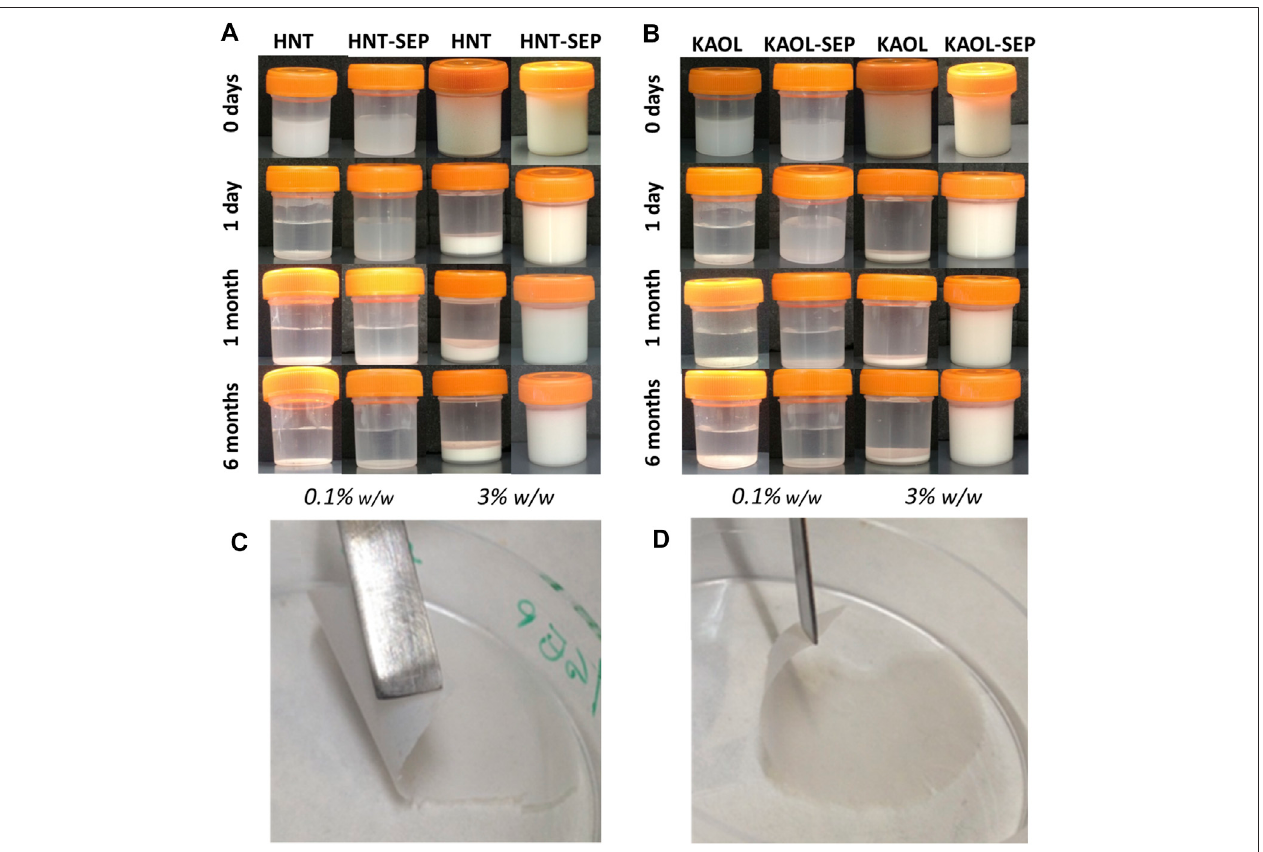
FIGURE 6 | Macroscopic aspect of 0.1 and 3.0 wt% aqueous dispersions of (A) pristine halloysite and HNT-SEP (1:5); (B) pristine kaolinite and KAOL-SEP (1:5); and picture of self-supported (C) HNT-SEP 1:5 fi lm and (D) KAOL-SEP 1:5 fi lm.